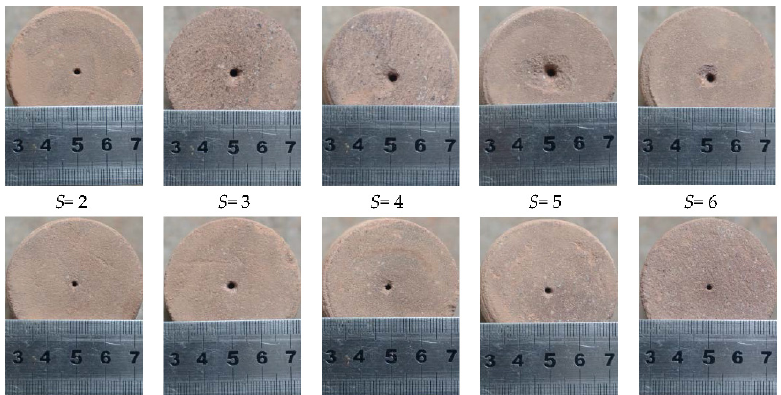
Figure 5. Photos of rock specimens after erosion: top ones for the nano-silica SC-CO 2 jet with a mass fraction of 12 wt %, bottom ones for the pure SC-CO 2 jet, P in = 50 MPa, P am = 15 MPa, T f = 340 K.